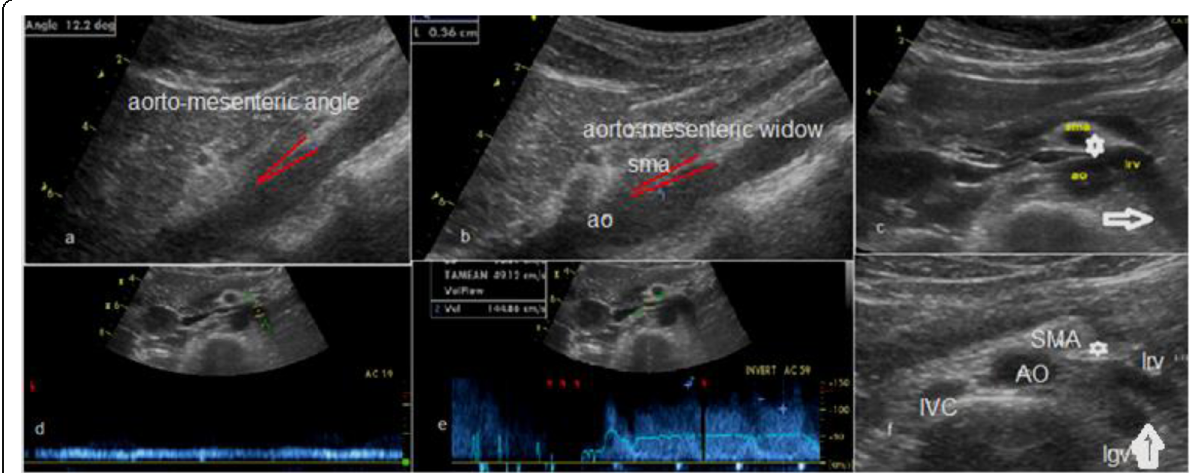
Fig. 8 a – f trans-abdominal and spectral Doppler images showing anterior nutcracker of the left renal vein evidenced by (narrow aorto- mesenteric angle = 12.2 degrees and narrow aorto-mesenteric window =3.6 mm between the red lines) in ( a , b ) significant left renal vein dilatation (open white arrow) in ( c ) being entrapped as it passed in the aorto-mesenteric window (white asterisk) in ( c ) between the aorta (ao) and superior mesenteric artery (sma); this was proven by spectral Doppler interrogation that showed significant rise in the velocity ratio in the nutcrackered segment of the vein ( d & e ). The left gonadal vein dilatation (open white arrow) in ( f ) was secondary to left renal vein nutcracker (white asterisk) in ( f ) as it passed in the aorto-mesenteric